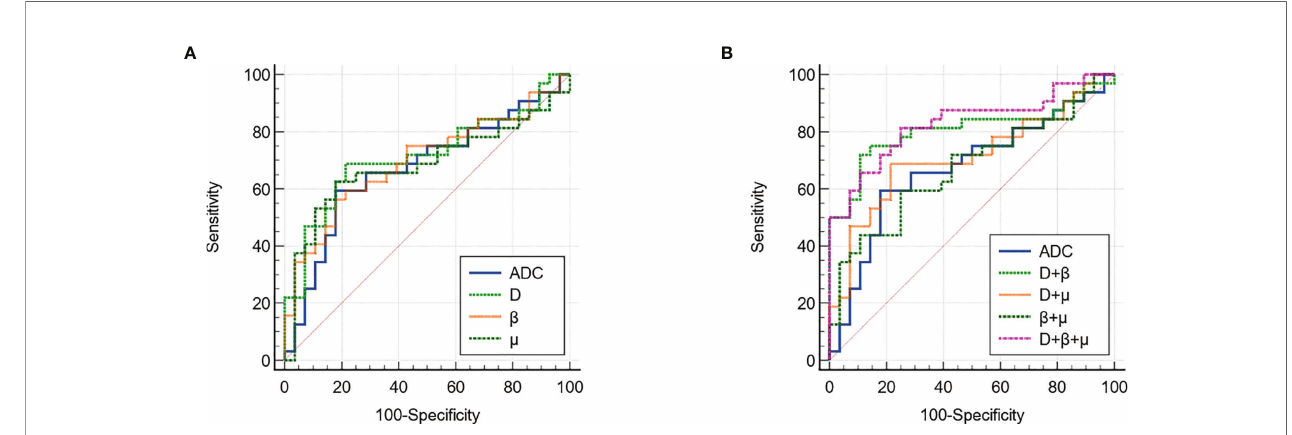
FIGURE 5 | The ROC curves of using (A) individual and (B) different combinations of FROC parameters for differentiation of low-grade tumor and high-grade tumor. ROC, receiver operating characteristic; FROC, fractional order calculus.